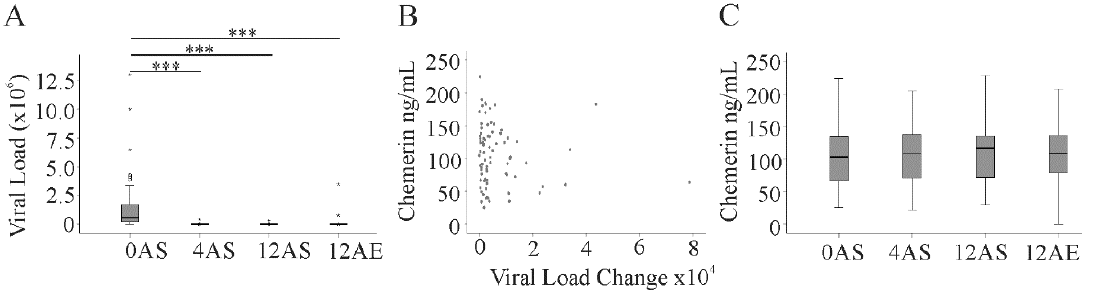
Figure 4. Viral load and serum chemerin during DAA therapy. ( A ) Viral load before (0), 4 and 12 weeks after start of therapy (AS), and 12 weeks after end of therapy (AE); ( B ) correlation of chemerin at the start of DAA therapy and change of viral load within 4 weeks of treatment; ( C ) chemerin at the times described in (A). Small circles or asterisks above the boxes mark outliers. *** p < 0.001. Table 3. Laboratory parameters of the patients at baseline, after 4 and 12 weeks of antiviral therapy, and 3 months after the end of treatment. Superscript numbers indicate the number of patients in case the laboratory values were not documented for the whole study group (alanine amino transferase (ALT), aspartate aminotransferase (AST), C-reactive protein (CRP). * p < 0.05, *** p < 0.001 (baseline compared to 3 months after therapy), %% p < 0.01, %%% p < 0.001 (baseline compared to 4 weeks therapy), $ p < 0.05, §§ p < 0.01 (baseline compared to 12 weeks therapy).